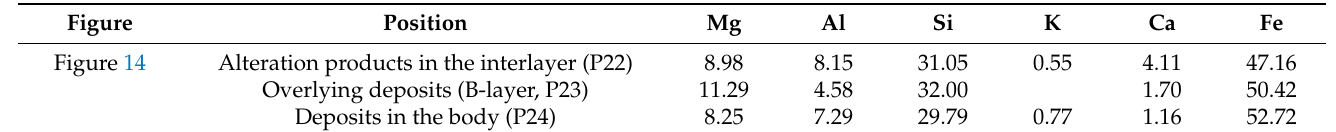
Table 4. EDS analysis results of the alteration products and deposits (wt%). Figure Position Mg Al Si K Ca Fe Figure 14 Alteration products in the interlayer (P22) Overlying deposits (B-layer, P23) Deposits in the body (P24)